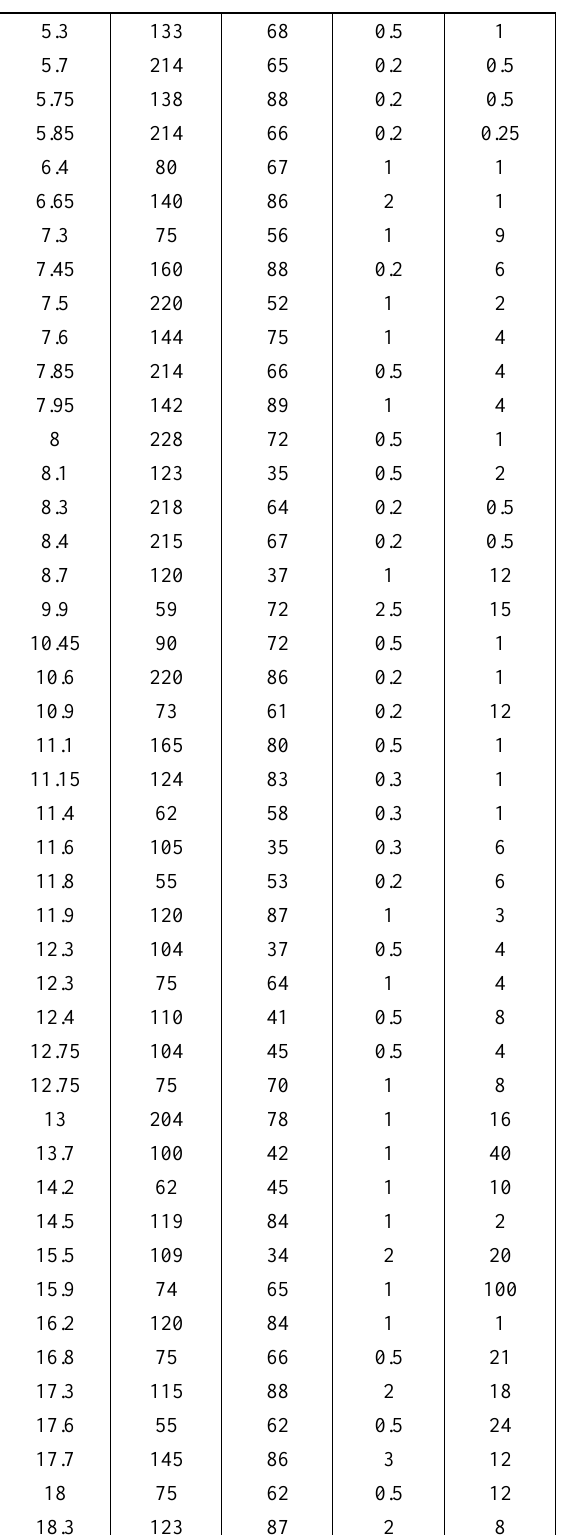
Table 1: Structural measurements of Mannsverk outcrop. Origin of linear coordinates is arbitrary. Dip direction convention follows compass clockwise rotation (as in Nxxx°E) aimed so with the down-to-the-right